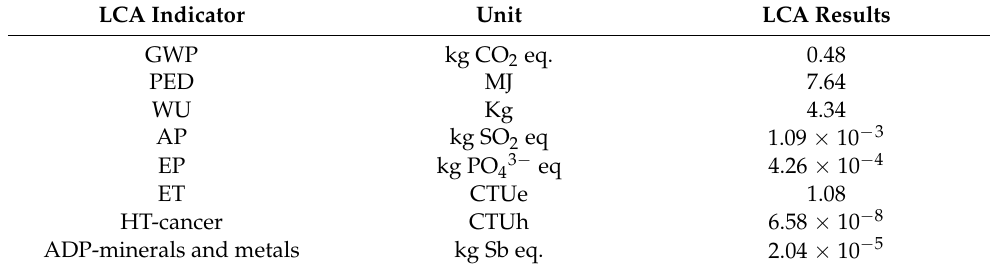
Table 6. Results for scenario